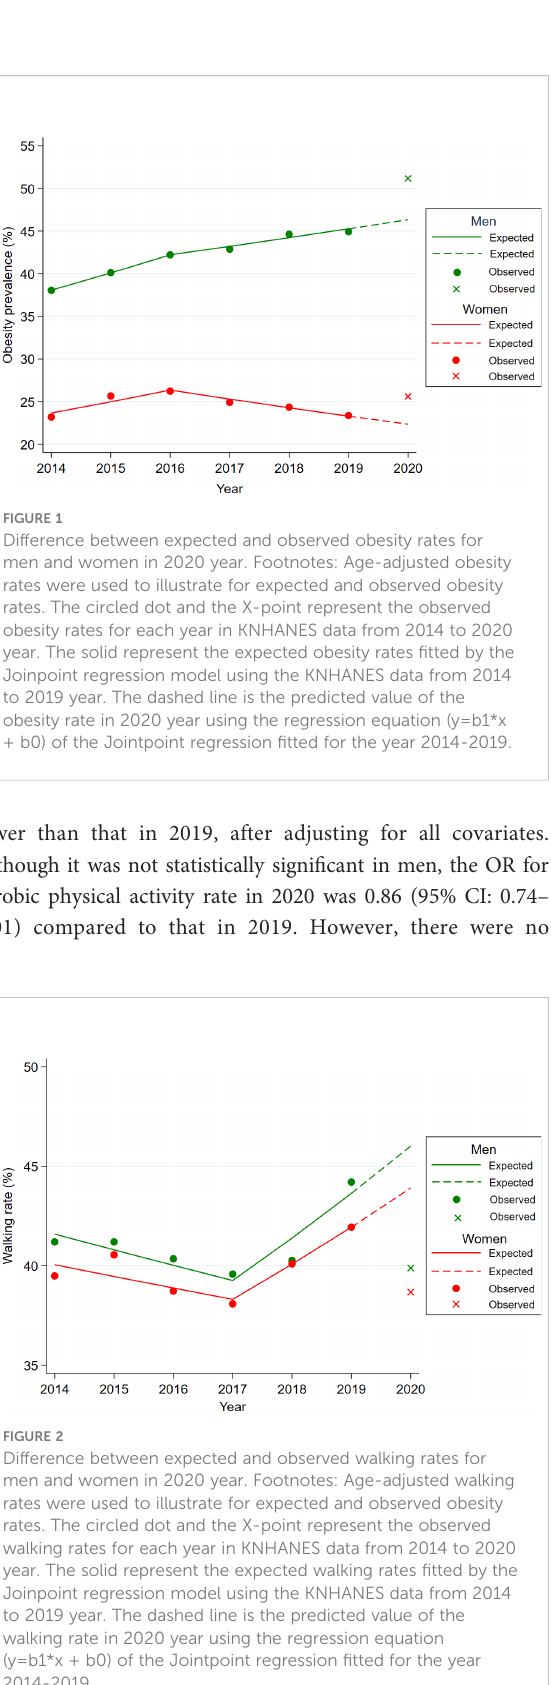
FIGURE 2 Difference between expected and observed walking rates for men and women in 2020 year. Footnotes: Age-adjusted walking rates were used to illustrate for expected and observed obesity rates. The circled dot and the X-point represent the observed walking rates for each year in KNHANES data from 2014 to 2020 year. The solid represent the expected walking rates fi tted by the Joinpoint regression model using the KNHANES data from 2014 to 2019 year. The dashed line is the predicted value of the walking rate in 2020 year using the regression equation (y=b1*x + b0) of the Jointpoint regression fi tted for the year 2014-2019.